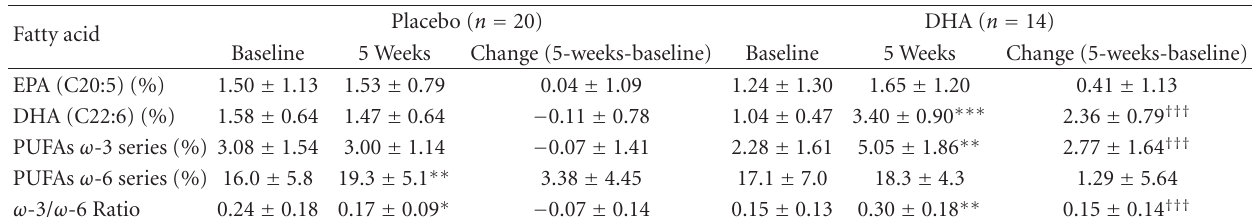
Table 3: ω -3 and ω -6 fatty acids in plasma phospholipids at baseline and at 5 weeks and change from the baseline. Placebo ( n = 20) DHA ( n = 14) Fatty acid Baseline 5 Weeks Change (5-weeks-baseline) Baseline 5 Weeks Change (5-weeks-baseline)